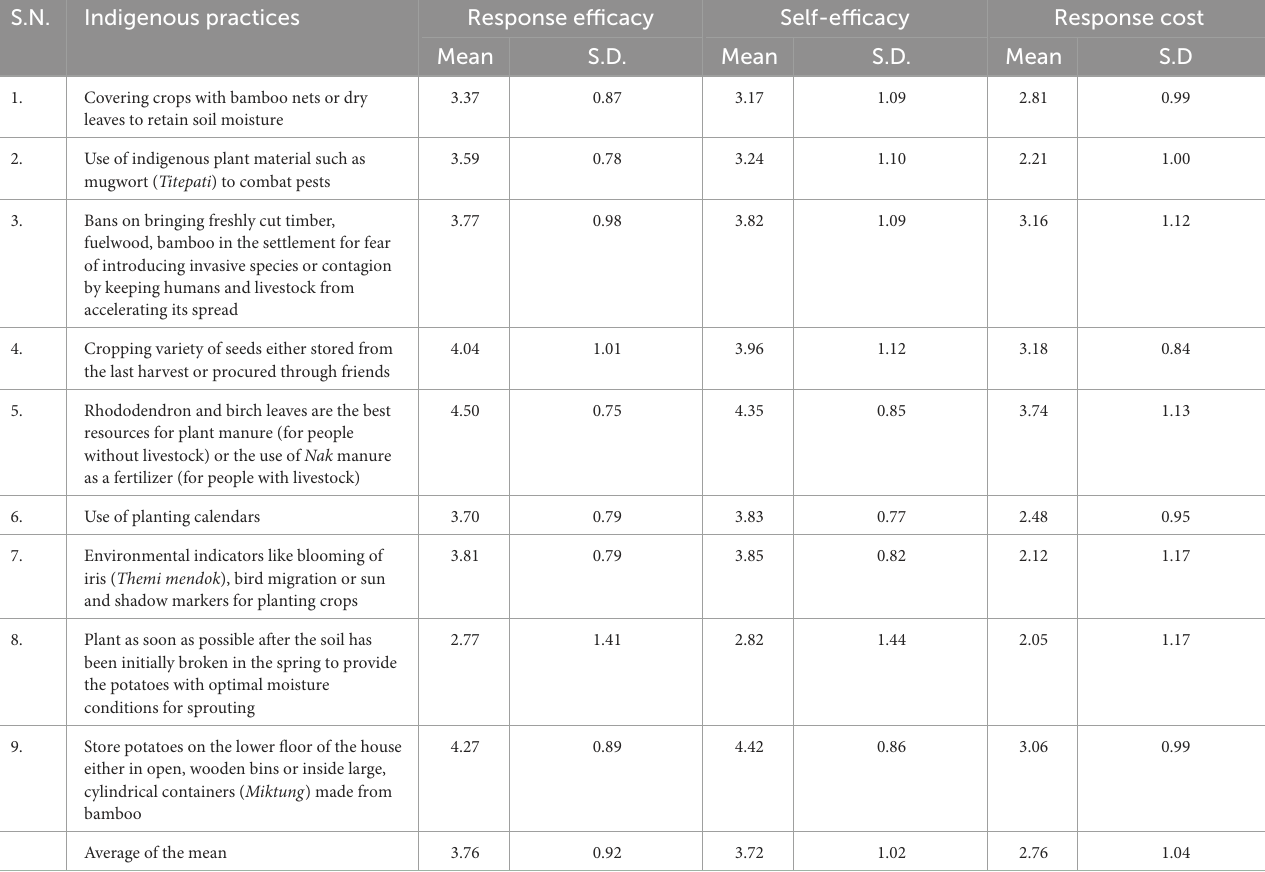
TABLE 3 Mean and standard deviation (S.D.) for the responses on the perception of adaptation efficacy.